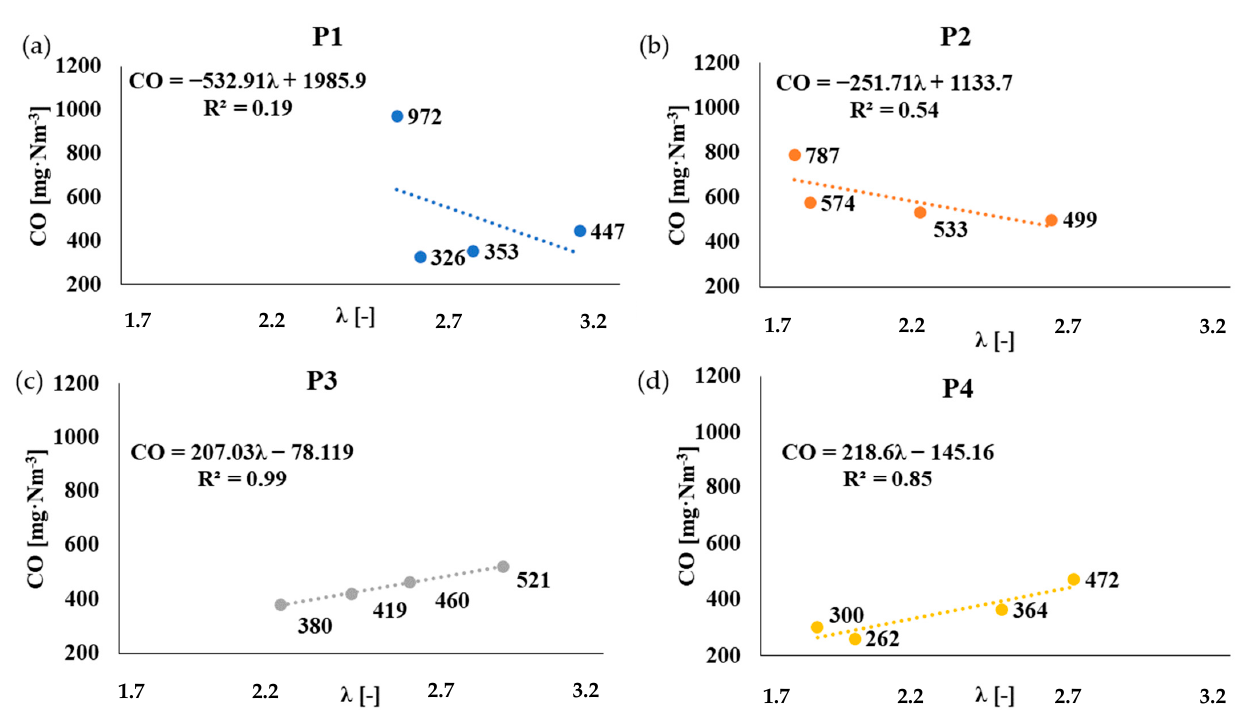
Figure 7. Emission of CO during pellet combustion in dependence on the air supplied to the combustion chamber ( a ) P1, ( b ) P2, ( c ) P3, and ( d ) P4.